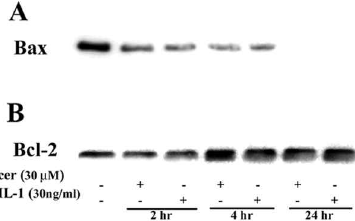
FIG. 4. A representative Western blot ( n = 4) showing: (A) the lack of effect of IEC treatment by IL-1 (30ng/ml) and/or ceramide on p53 levels, and (B) the decrease in p21 levels by IL-1 and/or